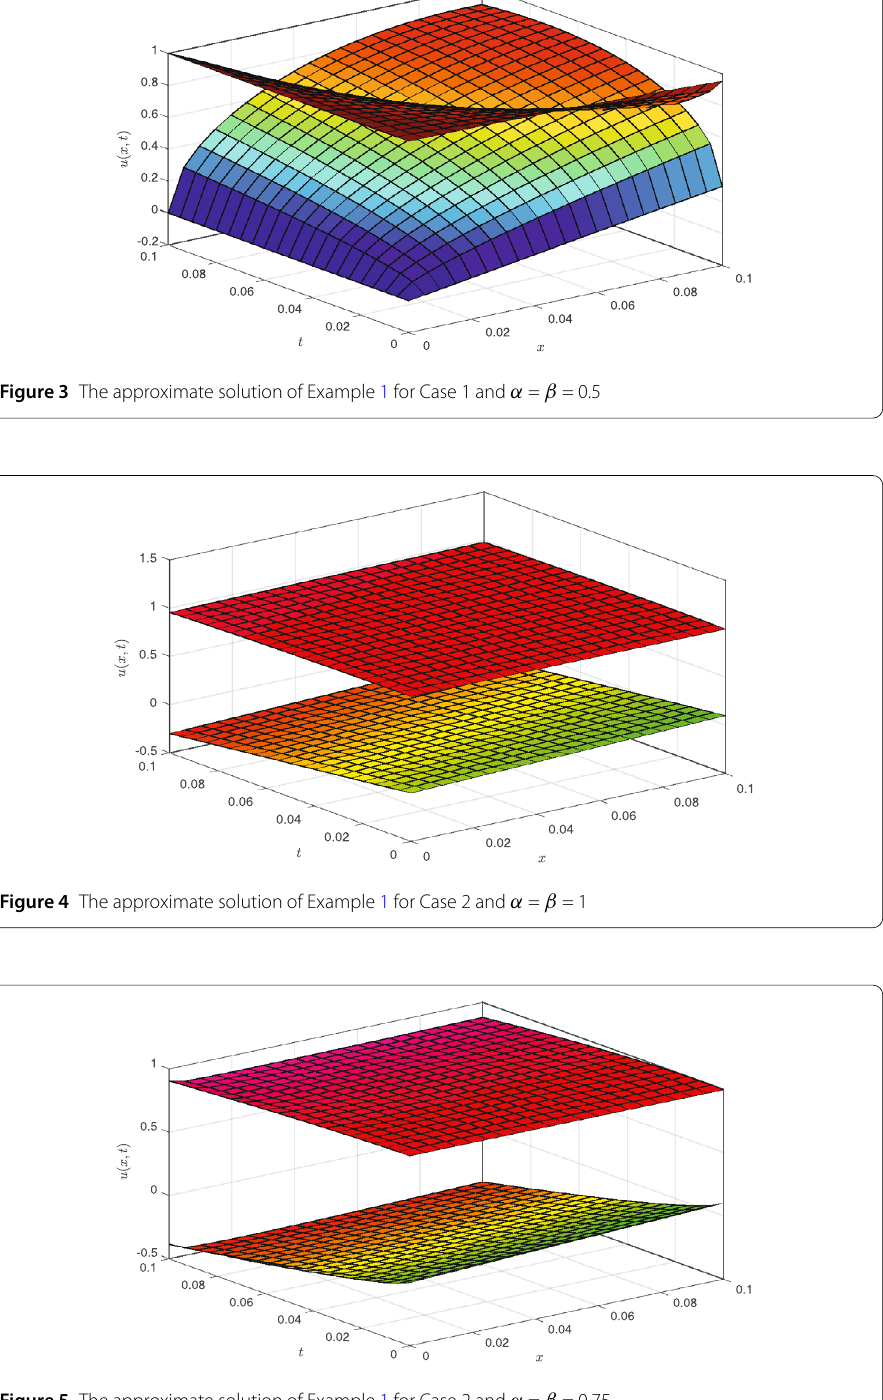
Figure 5 The approximate solution of Example 1 for Case 2 and α = β =